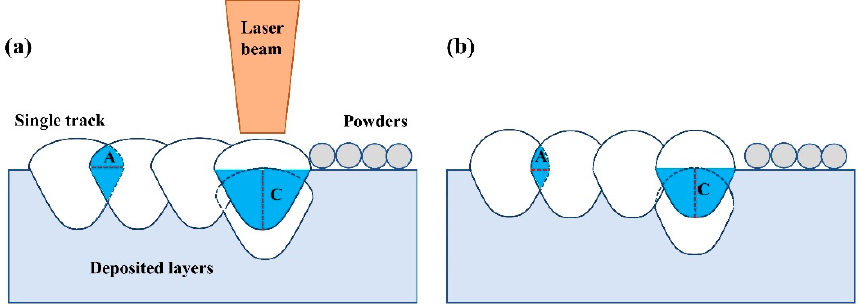
Figure 13. The schematic diagram of the overlap between single tracks: ( a ) the single track with large depth and width; ( b ) the single track with small depth and width.